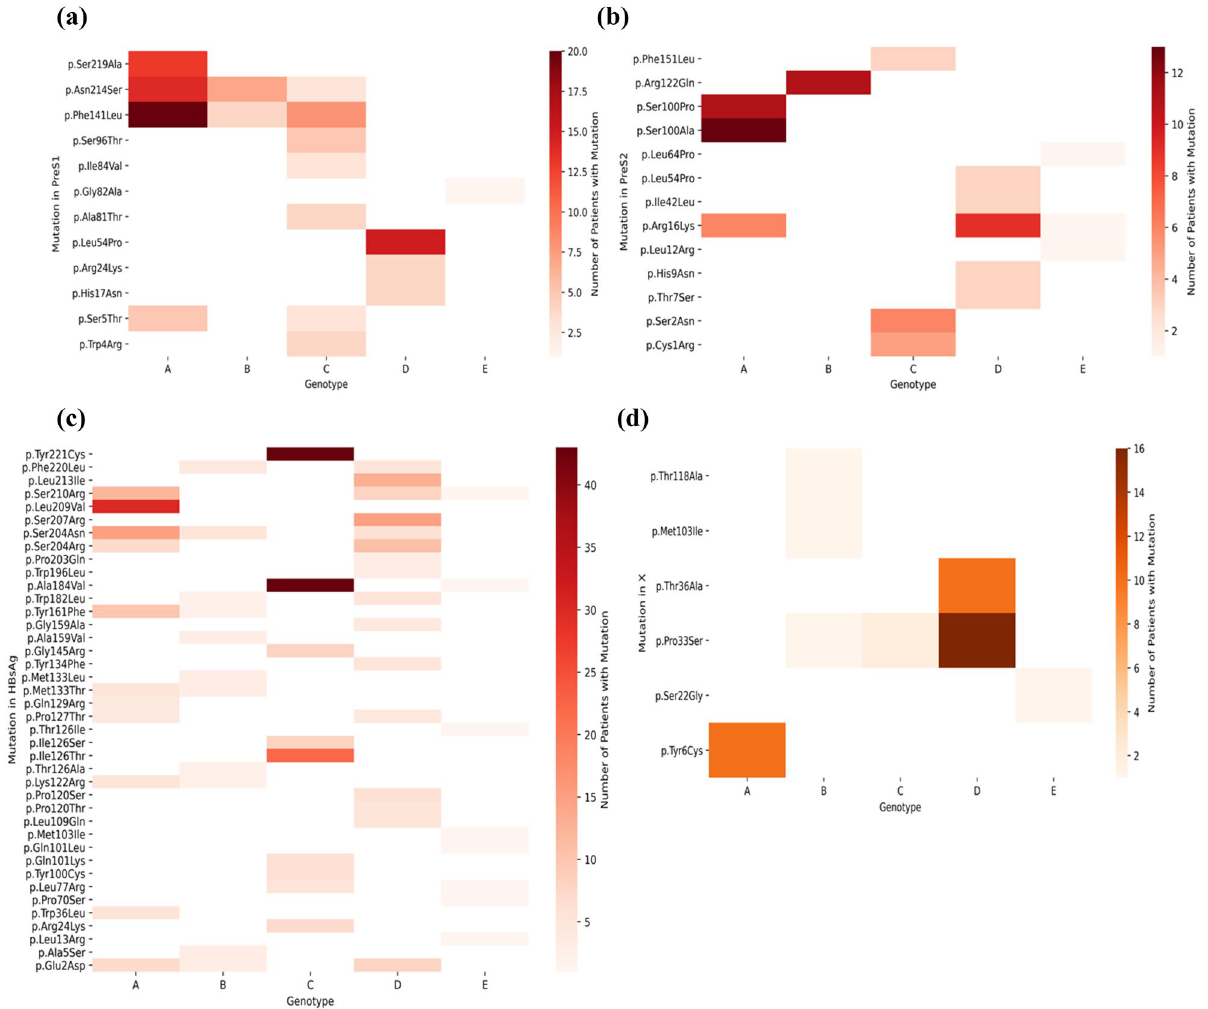
Figure 5. Heatmap of mutation hotspots for gene S in genotypes A-E: ( a ) HBV PreS1, and ( b ) HBV PreS2; heatmap of mutation hotspots for: ( c ) HBV HBsAg (gene S), and (d) HBV gene X in genotypes A-E. The white regions represent counts of mutations that are null, while dark red indicates the largest number of mutations.